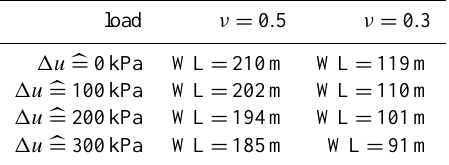
Table 1. Critical water level (WL) at 249 m crack depth in a 250 m thick ice shelf for different loads and Poisson’s